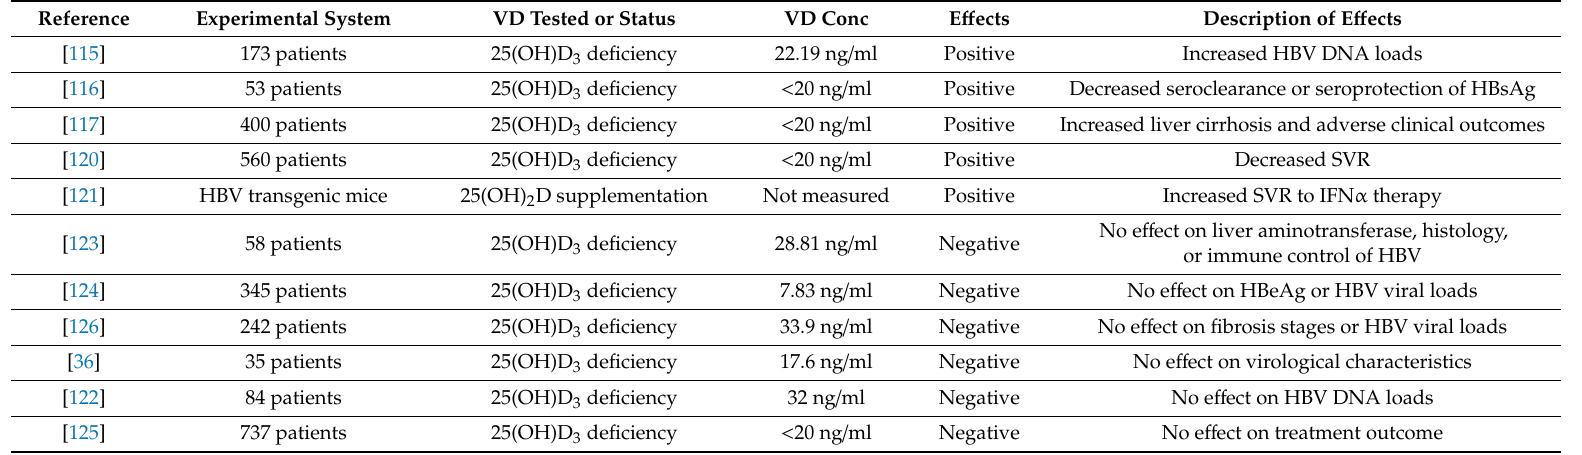
Table 3. E ff ects of VD on hepatitis B virus (HBV) infection, pathogenesis, and treatment